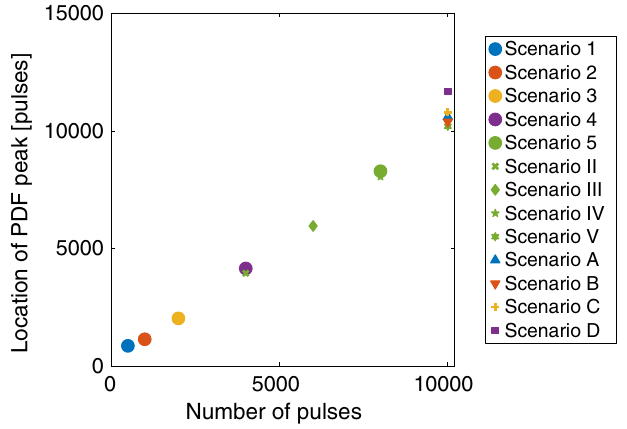
FIG. 4. Location of the maximum value of each PDF in 3 as a function of the number of pulses in the voltage recovery scenario.